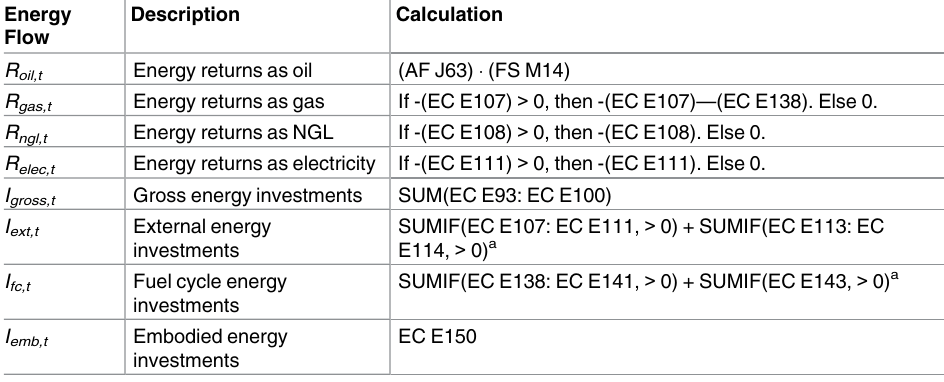
Table 2. Calculation of NER and EER flows from OPGEE model cells. Calculations based partially on the method of Brandt et al.